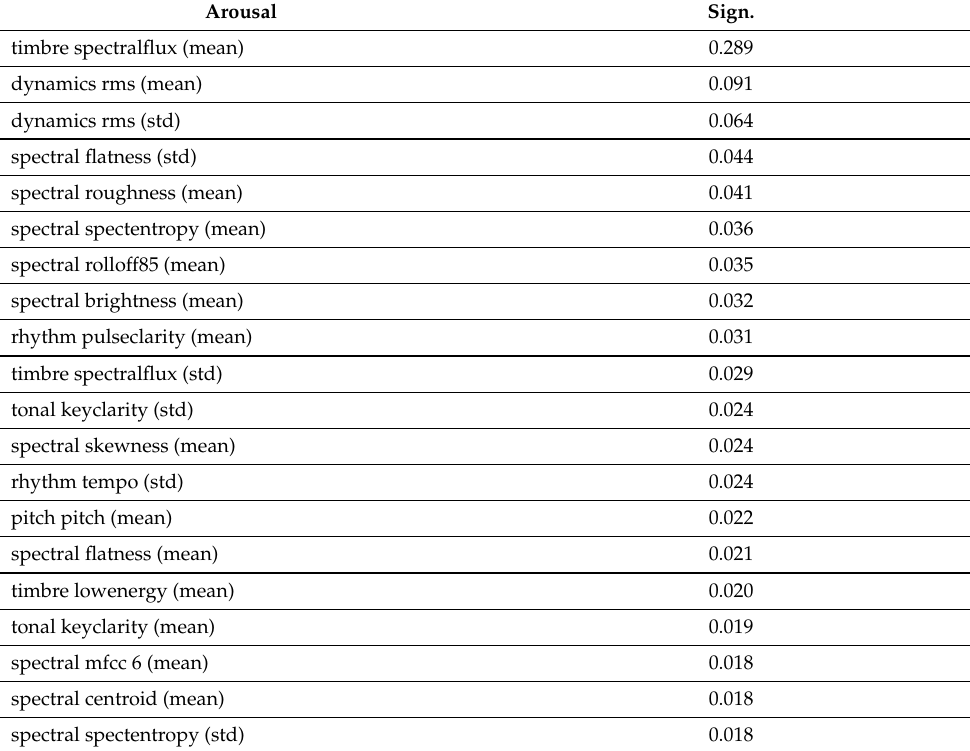
Table 9. Sorted significant features for arousal (25 features), valence (nine features), and dominance (seven features) by using RFE and applying the RF model on the IADSE